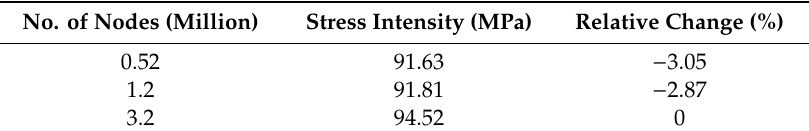
Table 6. Results of grid independence test for CD tube.